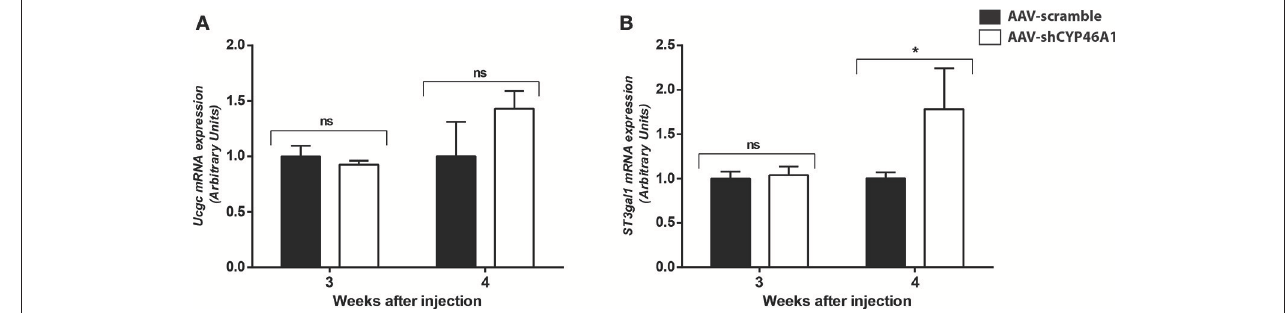
FIGURE 6 | Quantitative expression of UDP-glucose ceramide glucosyltransferase (UCGC) (A) and ST3 beta-galactoside alpha-2,3-sialyltransferase (ST3GAL1) (B) after hippocampal injections of AAV-scramble and AAV-shCYP46A1 vectors. Quantitative expression of murine Ucgc (A) , St3gal1 (B) genes were performed 3 and 4 weeks post-injection ( n = 5 mice). Expression data are normalized to the expression of AAV-scramble (control). Unpaired t -test was performed. * P < 0.05; ns,